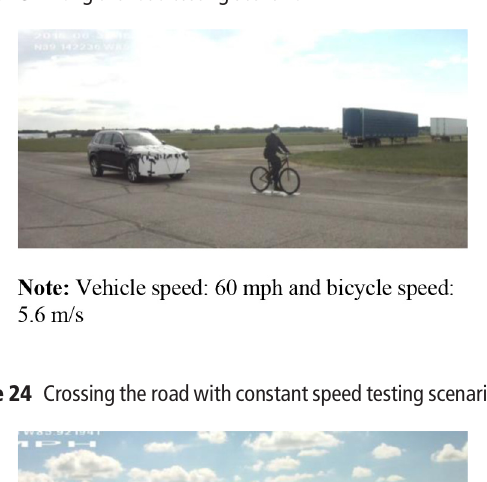
Figure 23 Along the road testing scenario